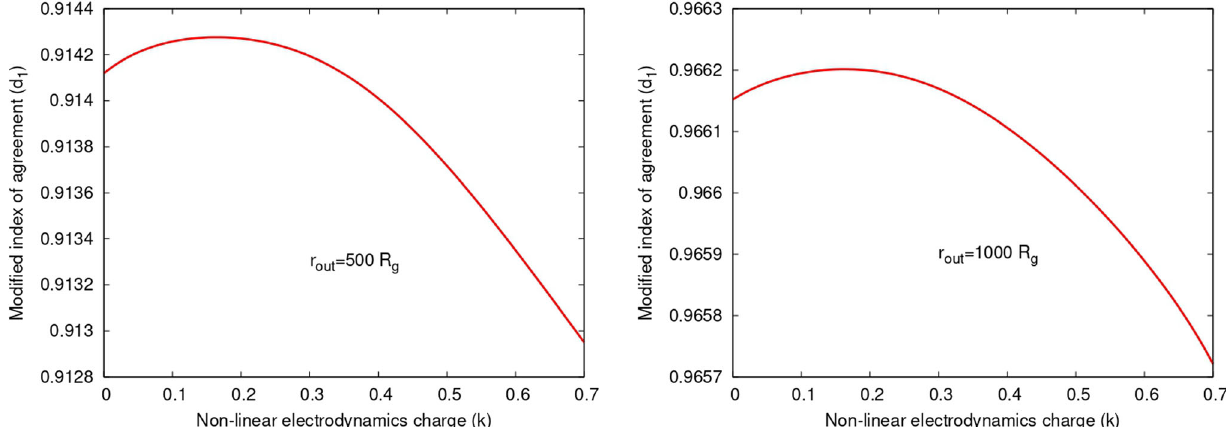
Fig. 6 The figure above depicts the variation of the modified index of agreement d 1 with the non-linear electrodynamics charge parameter k . In the left panel d 1 is computed with r out = 500 r g while in the right panel d 1 is evaluated with r out = 1000 r g . In both cases d 1 maximizes